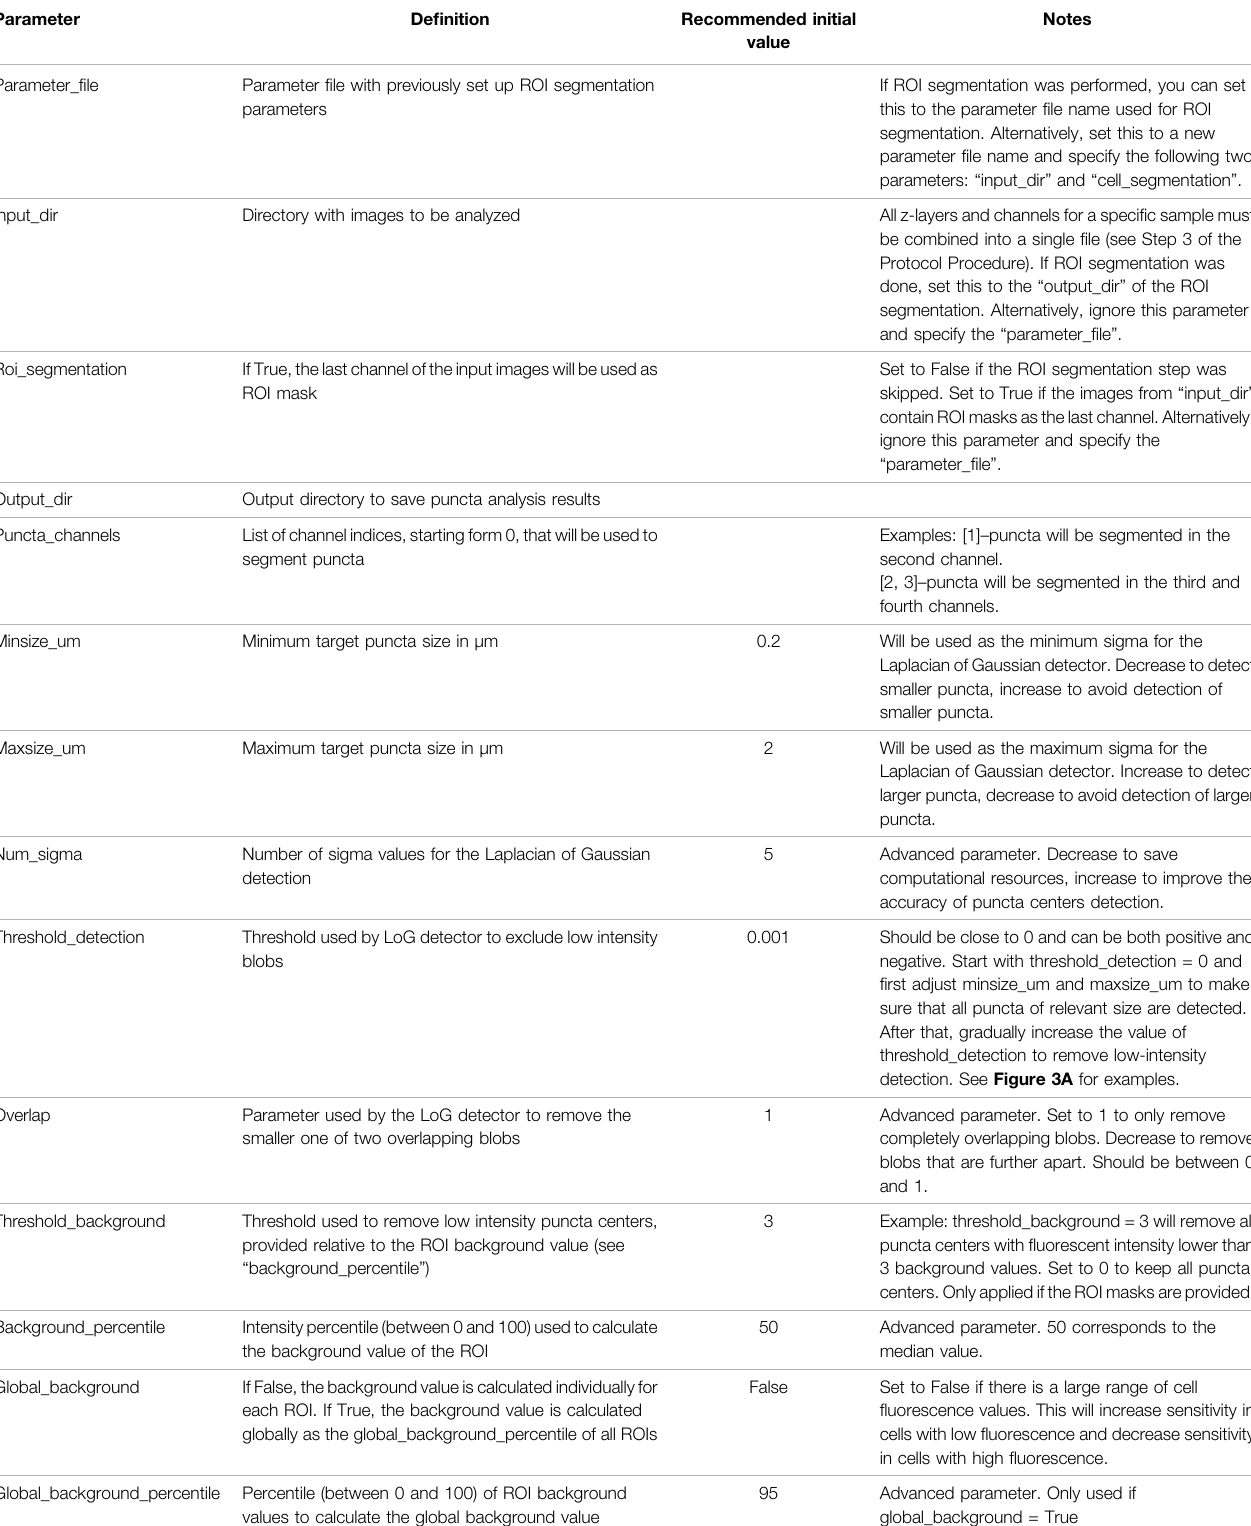
TABLE 2 | List of parameters for puncta segmentation and analysis